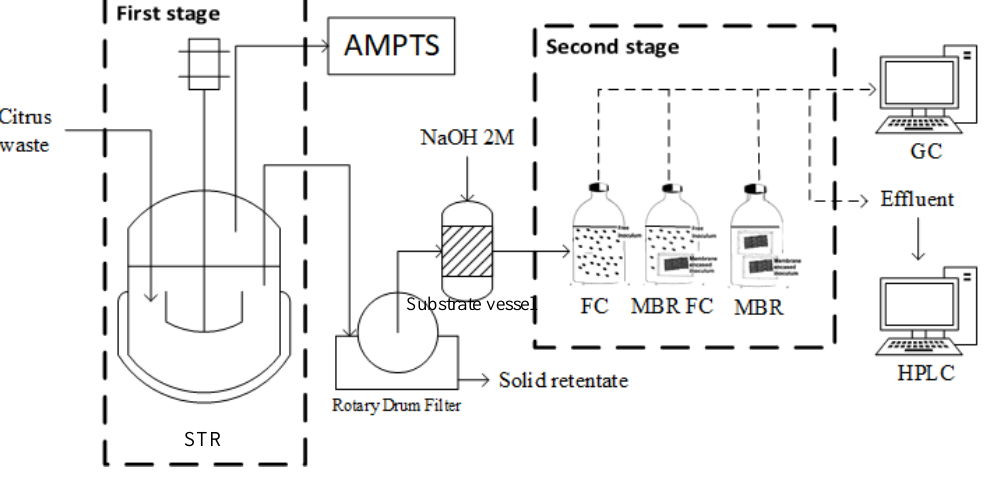
Figure 1. Experiment schematic diagram showing both the first and second stages. STR = stirred Tank Reactor. AMPTS = Automatic Methane Potential Test System. FCs = freely suspended cells. rMBR–FCs = combination of freely suspended cells and reverse membrane bioreactors. rMBR = reverse membrane bioreactor.